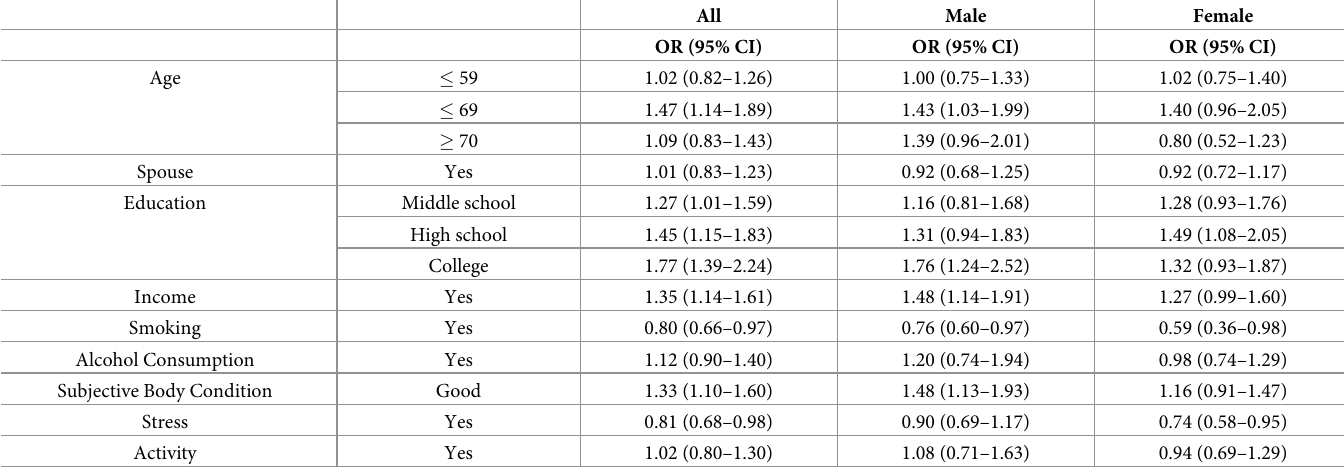
Table 5. Analysis of affective factors for regular